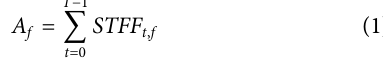
Frontiers in Mechanical Engineering |